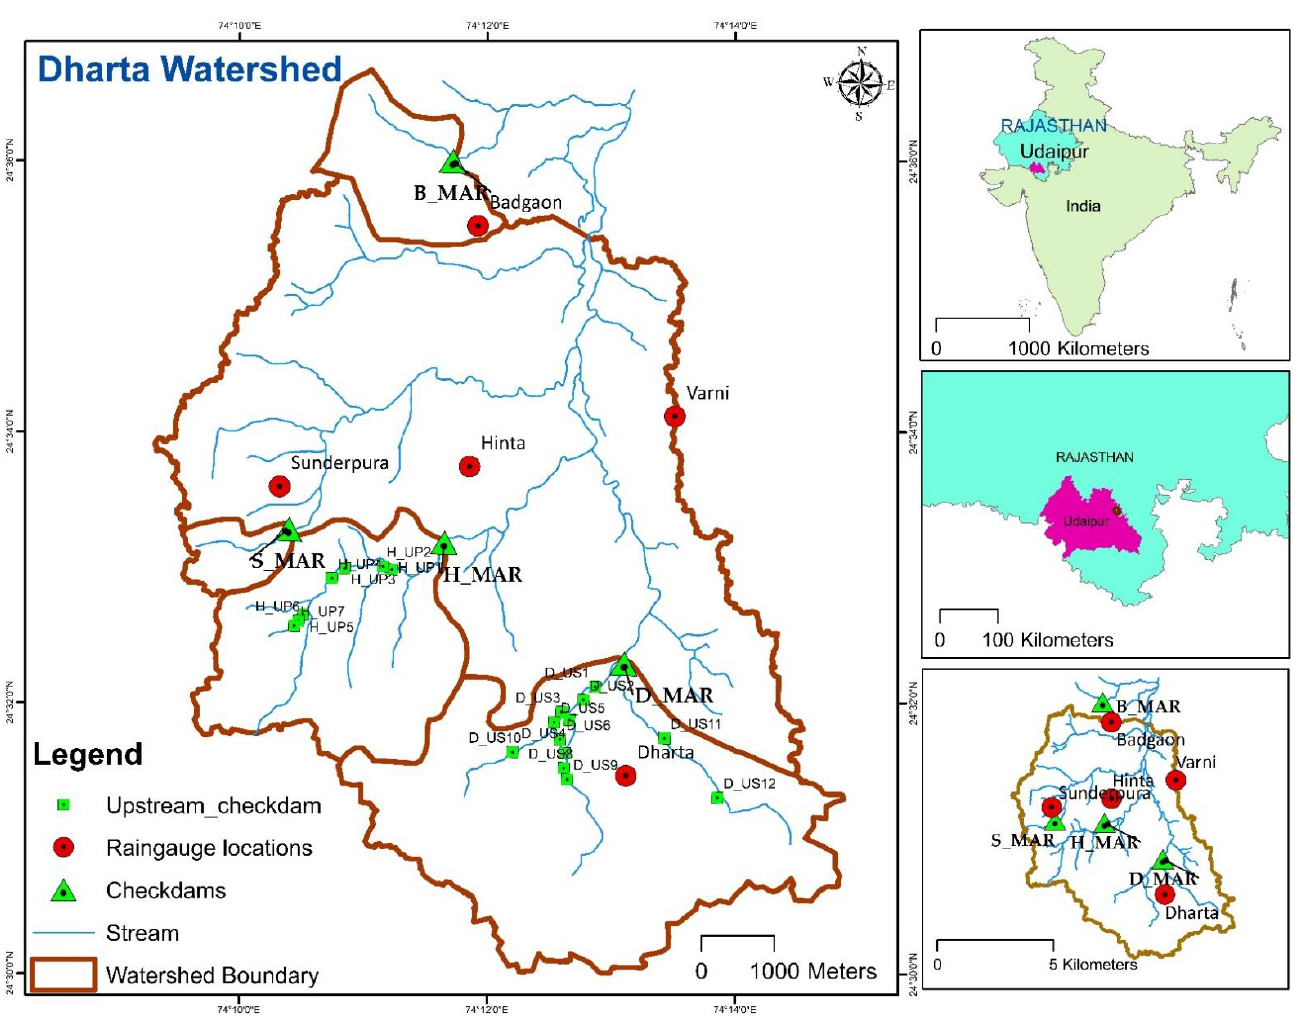
Figure 1. Map of the Dharta catchment showing the four monitored check dams and the identified check dams constructed in 2017, 12 upstream of the Dharta check dam (total capacity 67 ML) and 7 upstream of the Hinta check dam (total capacity 34 ML). 1 ML = 10 3 m 3 .